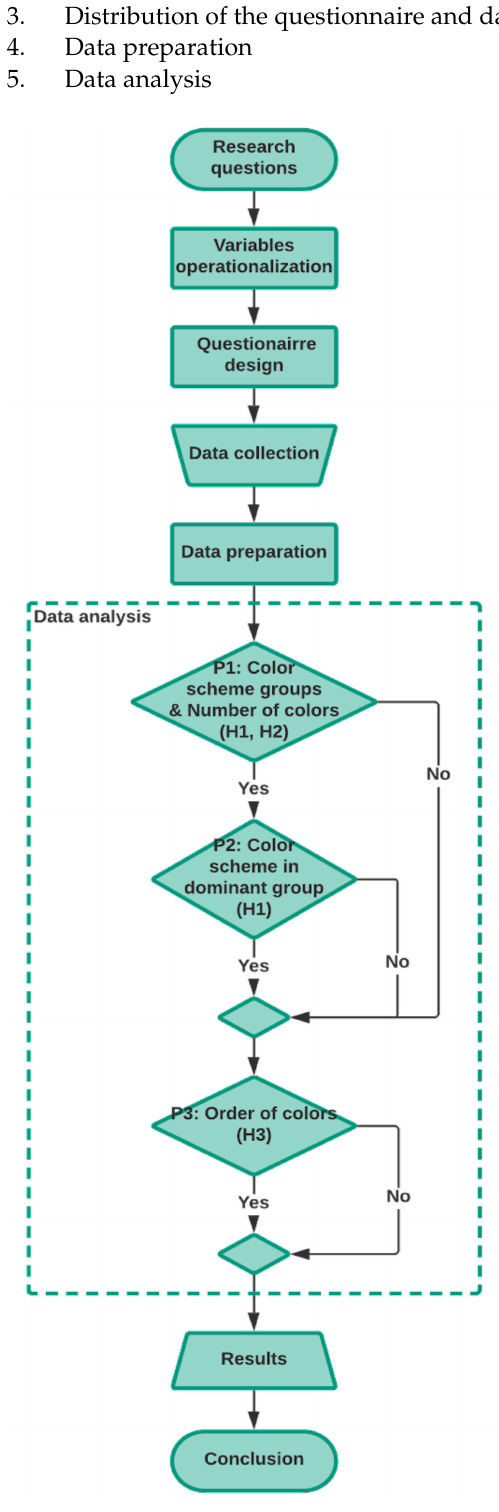
Figure 4. Experimental research